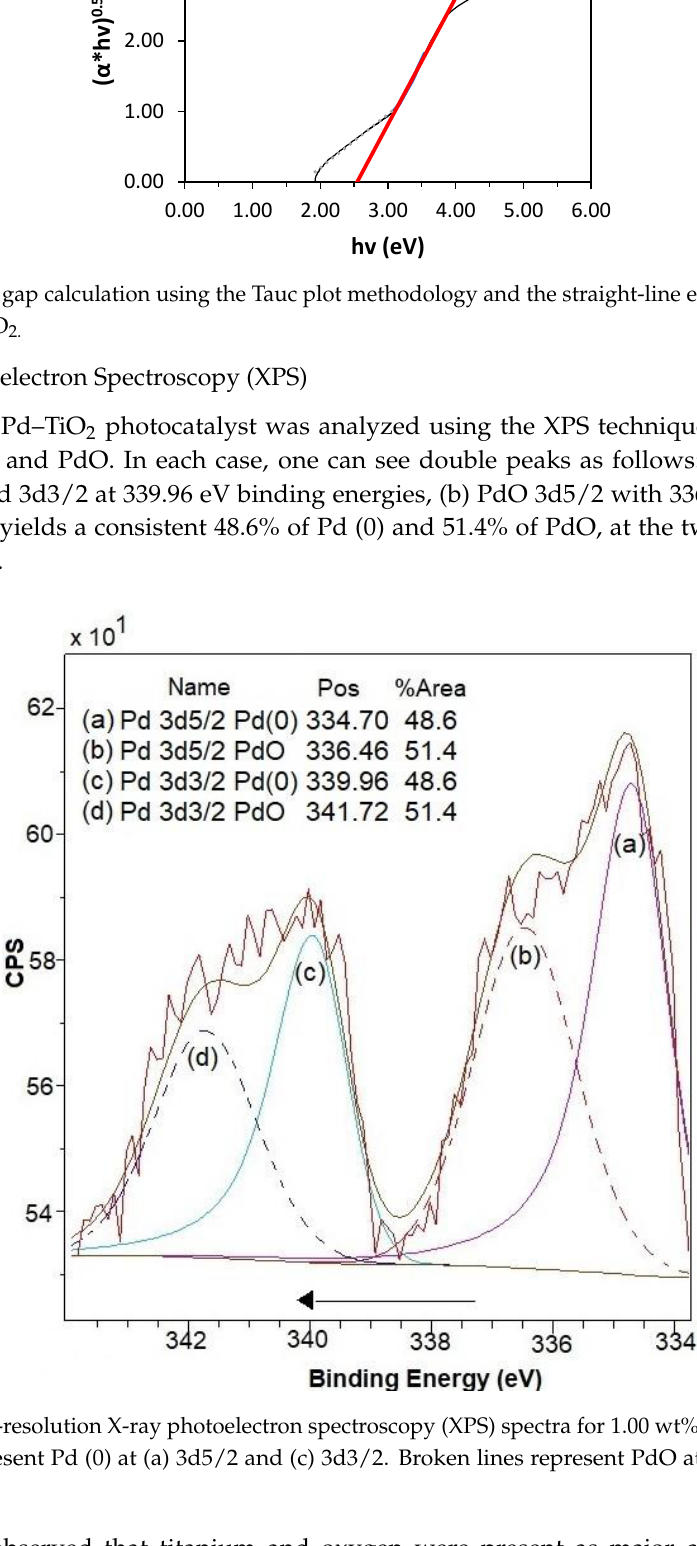
Figure 2. Effect of Pd loading on the optical band gap .